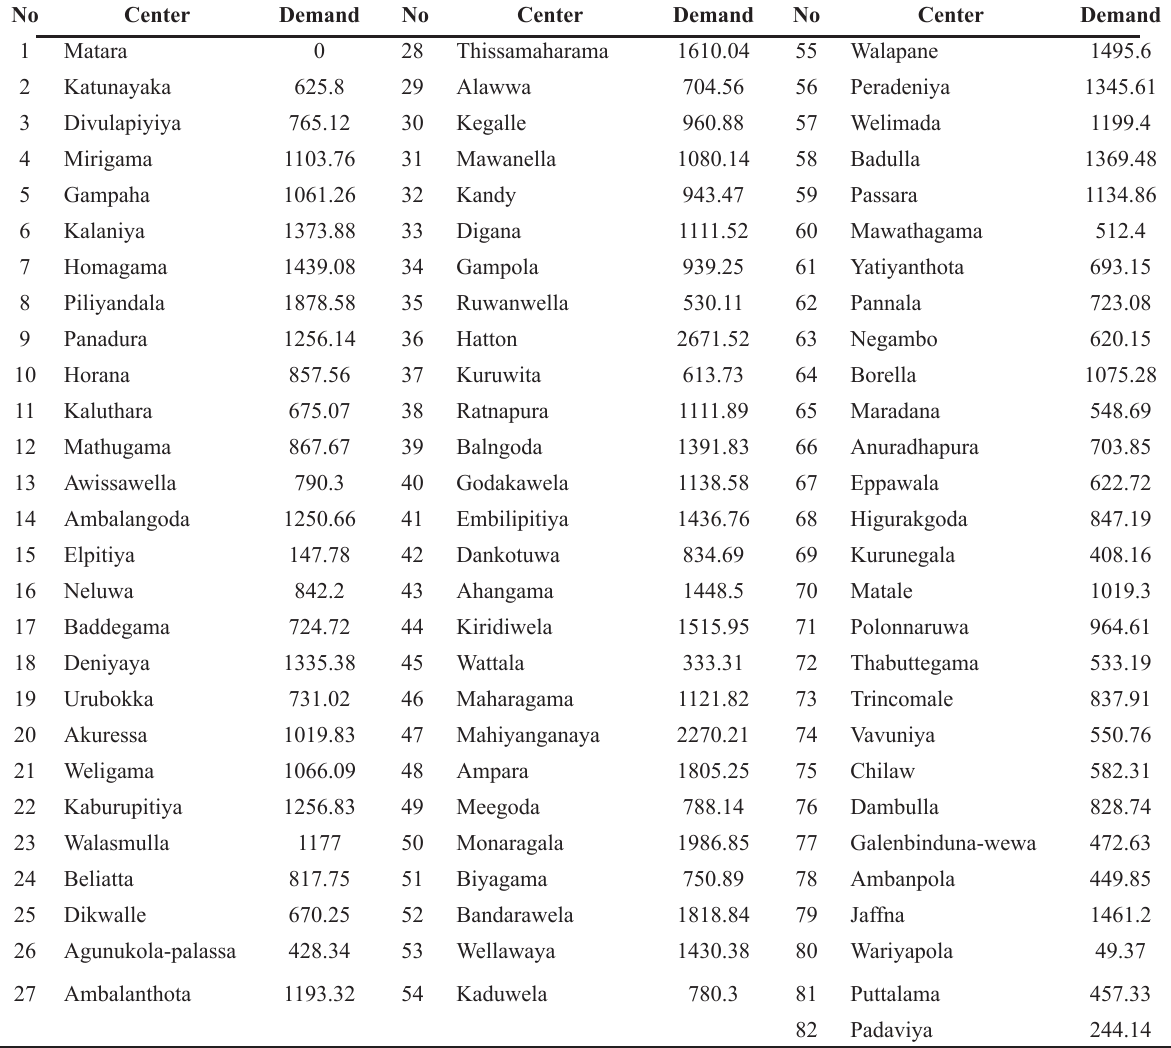
Table 1: Weekly predefined demands of the sub-distribution